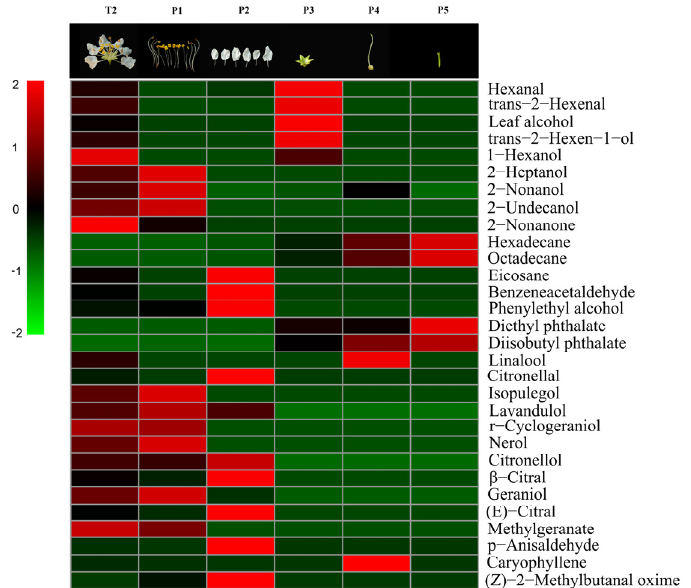
Figure 7. Heat-map with volatiles identified from a single flower and its five floral organs in L.